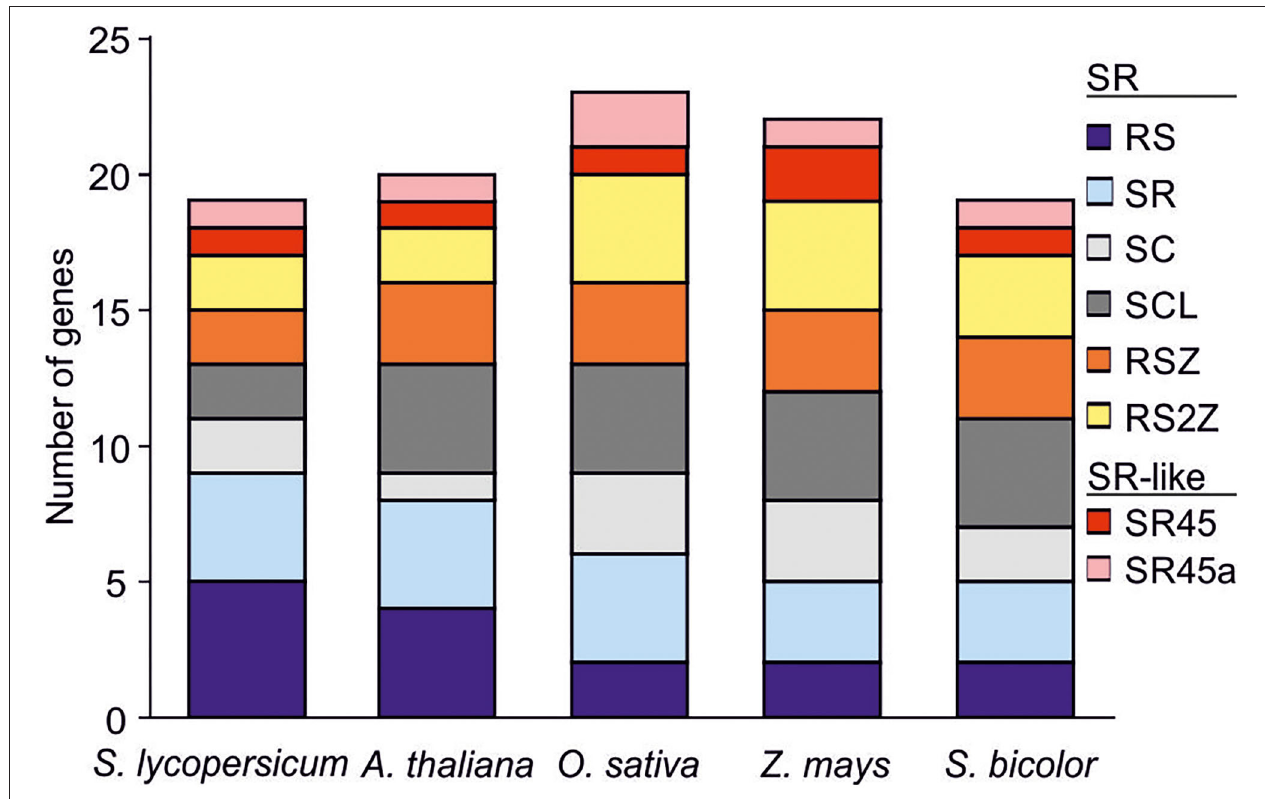
FIGURE 1 | SR co-orthologs in different plant species. Co-orthologs of SR and SR-like proteins in tomato using previously characterized members from four plant species as bait ( Tanabe et al., 2009; Richardson et al., 2011). Abbreviations are explained in text.